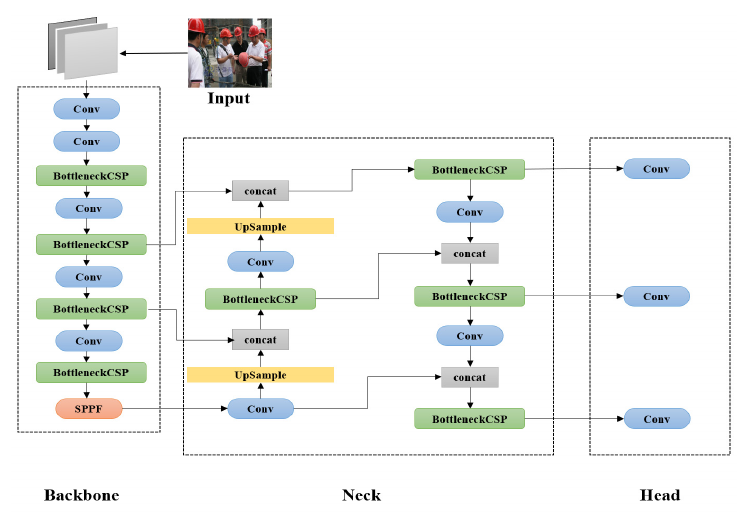
Figure 1. The network model of YOLOV5s.